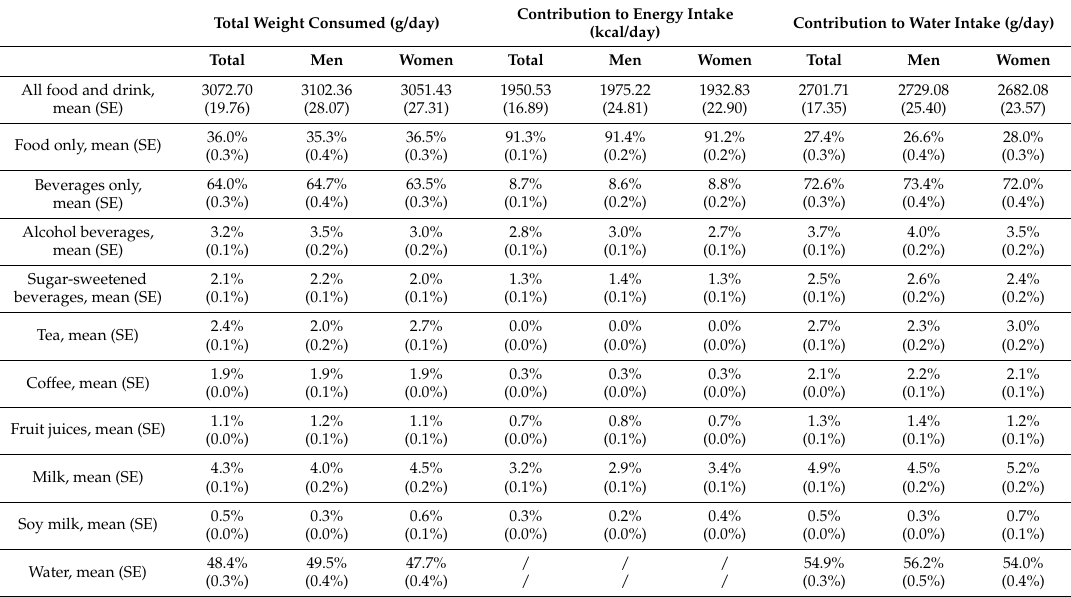
Table 3. Contribution of food and beverages to total water and energy intake.